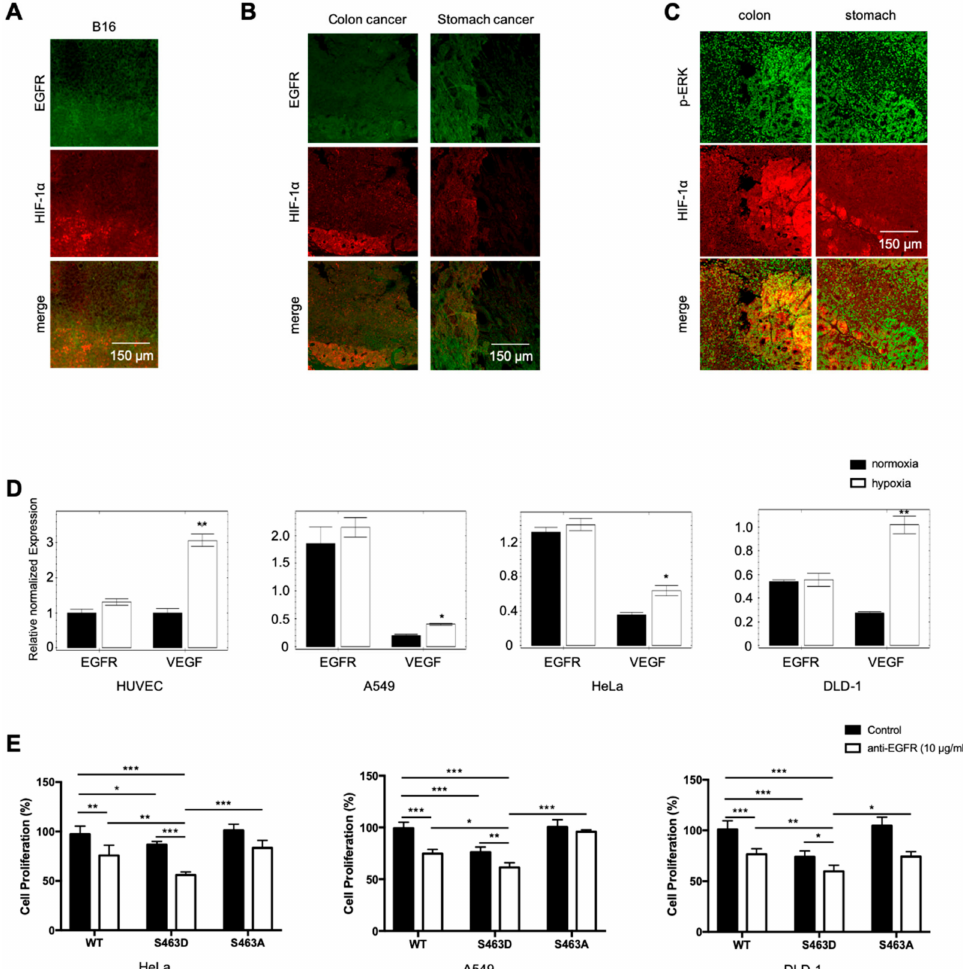
Figure 4. Activation of lysosomes enhances tumor cell response to anti-EGFR inhibition. Cryosectioned murine B16 melanoma tissues were stained with antibodies against EGFR and HIF-1 α and imaged with confocal microscopy ( A ). Para ffi n sections of human colon and stomach cancer tissues were stained against EGFR and HIF-1 α ( B ) and p-ERK and HIF-1 α ( C ) and imaged with confocal microscopy. Representative images are shown. HUVEC, A549, HeLa, and DLD-1 were incubated in 20% or 1% O 2 for 5 h. The mRNA levels of EGFR and VEGF were measured by qPCR ( D ). * p < 0.05, ** p < 0.01. Human tumor cells transfected with WT TFEB, or S463A and S463D mutant expression vectors were treated with control IgG or anti-EGFR antibodies at 10 µ g / mL overnight. Cell proliferation was measured by the XTT assay ( E ). * p < 0.05, ** p < 0.01, *** p < 0.001. The experiment was done in triplicates and repeated